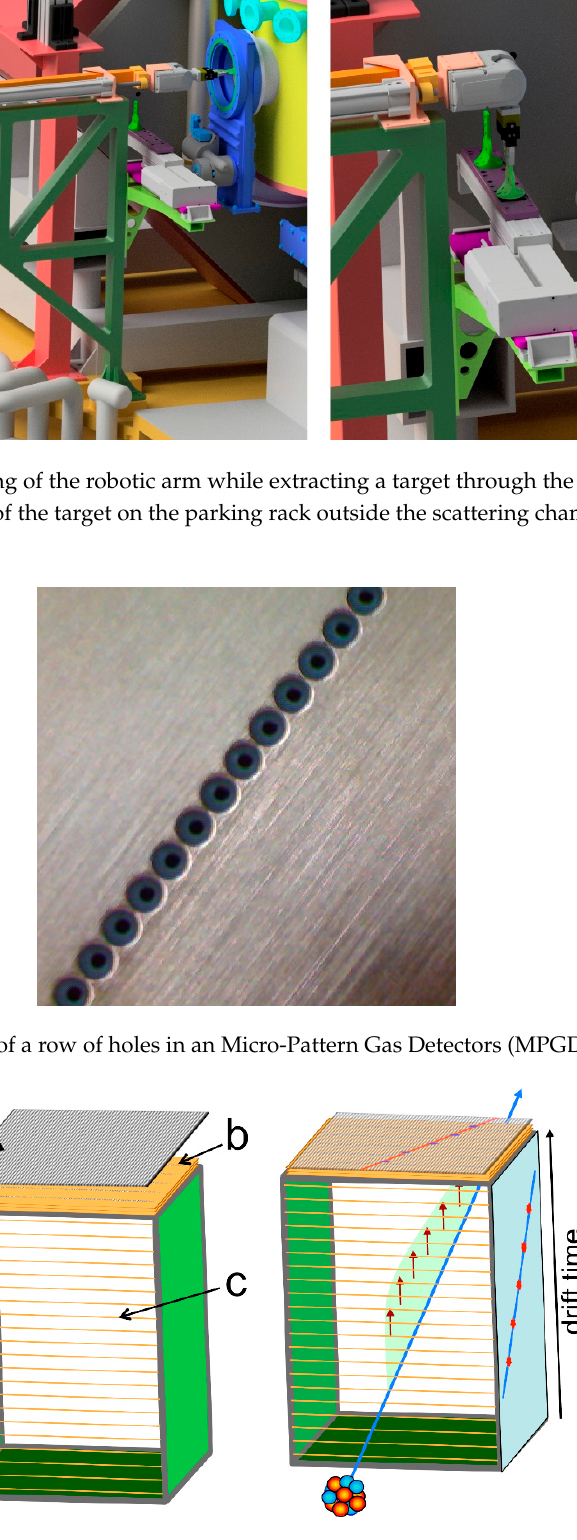
Figure 8. Operating principle of the gas Tracker. Left : (a) readout plane with finely spaced strip electrodes; (b) three MPGD planes with five rows of electron multiplying holes orthogonal to the strips; (c) drift field shaping wires. Right : each particle track produces five points on the XZ plane and five on the YZ plane, whose linear fits give rise to the desired quantities.